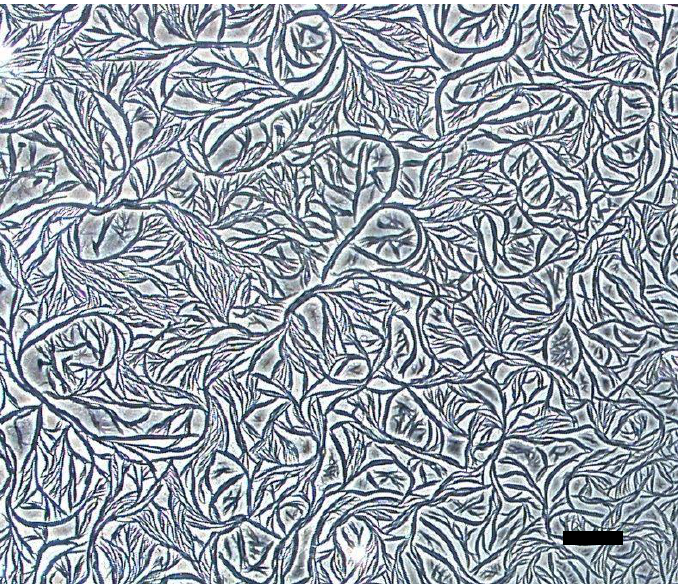
Figure 8. Optical microscopy images of mesomorphic phases of 6 in dimethylformamide (DMF). Scale bar is 50 μm.